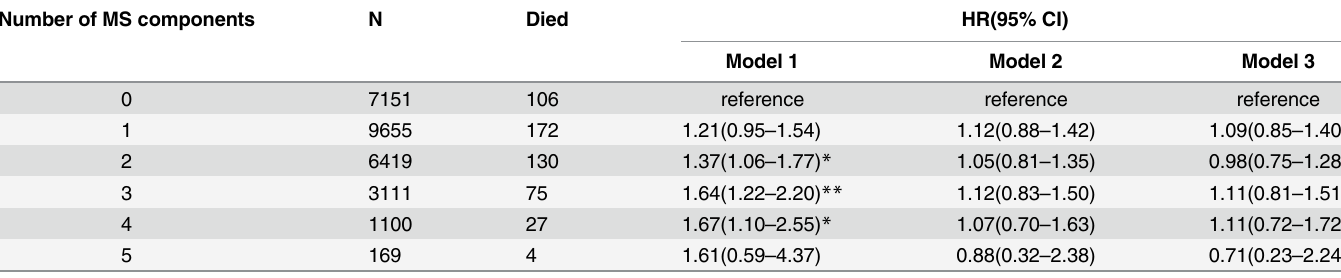
Table 6. Relationships between different number of MS components and all-cause mortality after exclude subjects with EH or T2DM or CKD. Number of MS components